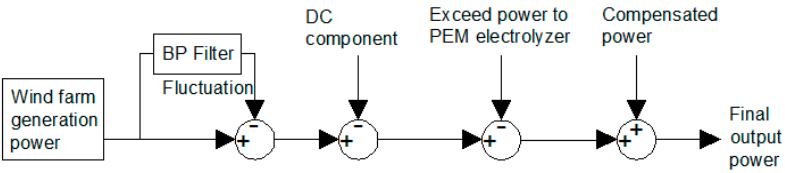
Figure 4. Energy flow diagram.